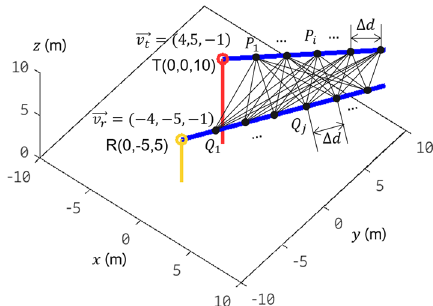
Fig. 8 An illustration of the way the proposed method